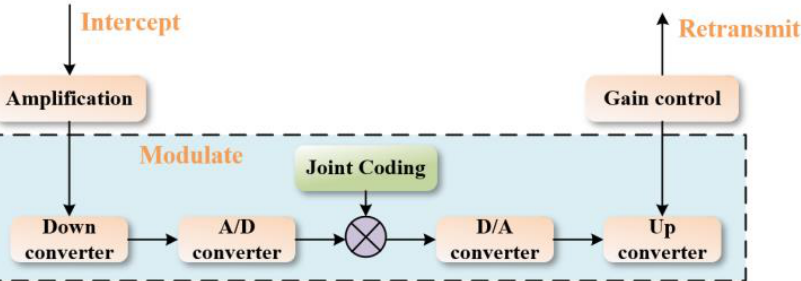
Figure 2. Working flow chart of a jammer.